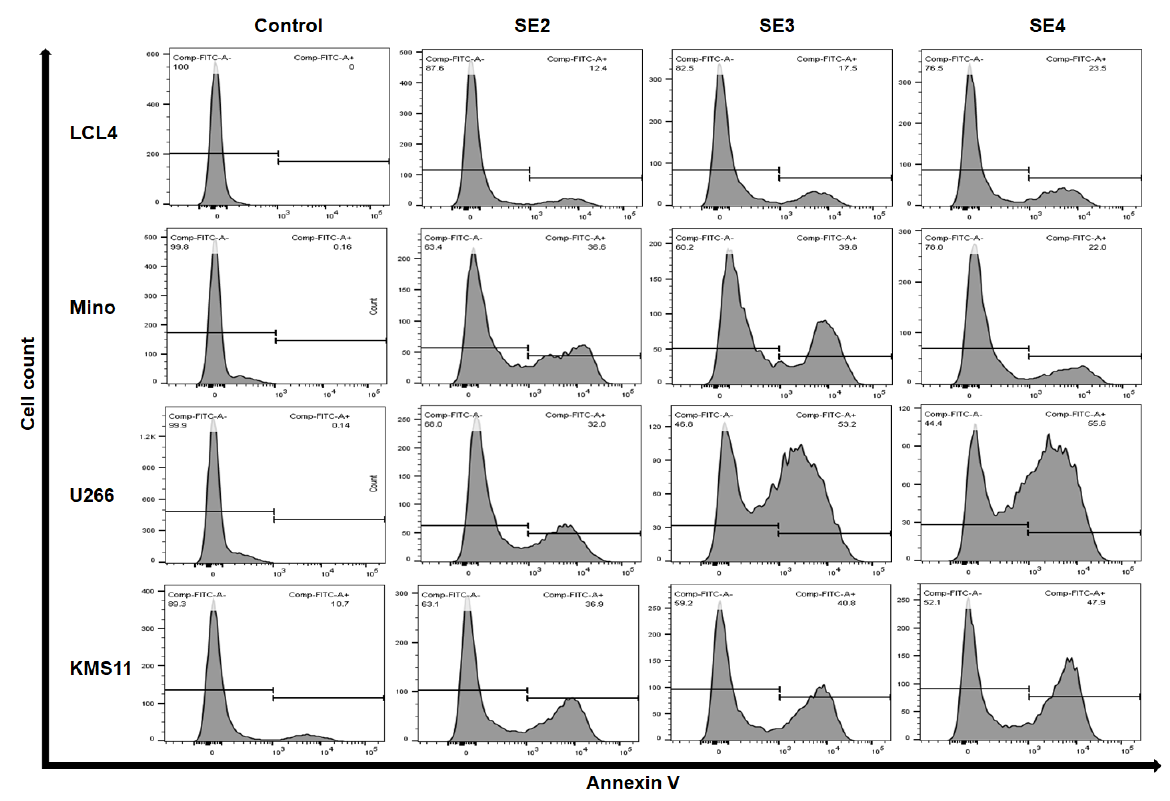
Figure 3. Apoptosis-inducing effect of SE2, SE3, and SE4 fractions against LCL, Mino, and U266 cell lines after 24 h. Cell count shows the number of cells, Comp_FITC_A - represents non-apoptotic cells, while Comp_FITC_A+ indicates apoptotic population. Table 4. Phytochemical components of active fractions from the ethyl acetate extract of C. speciosa roots by